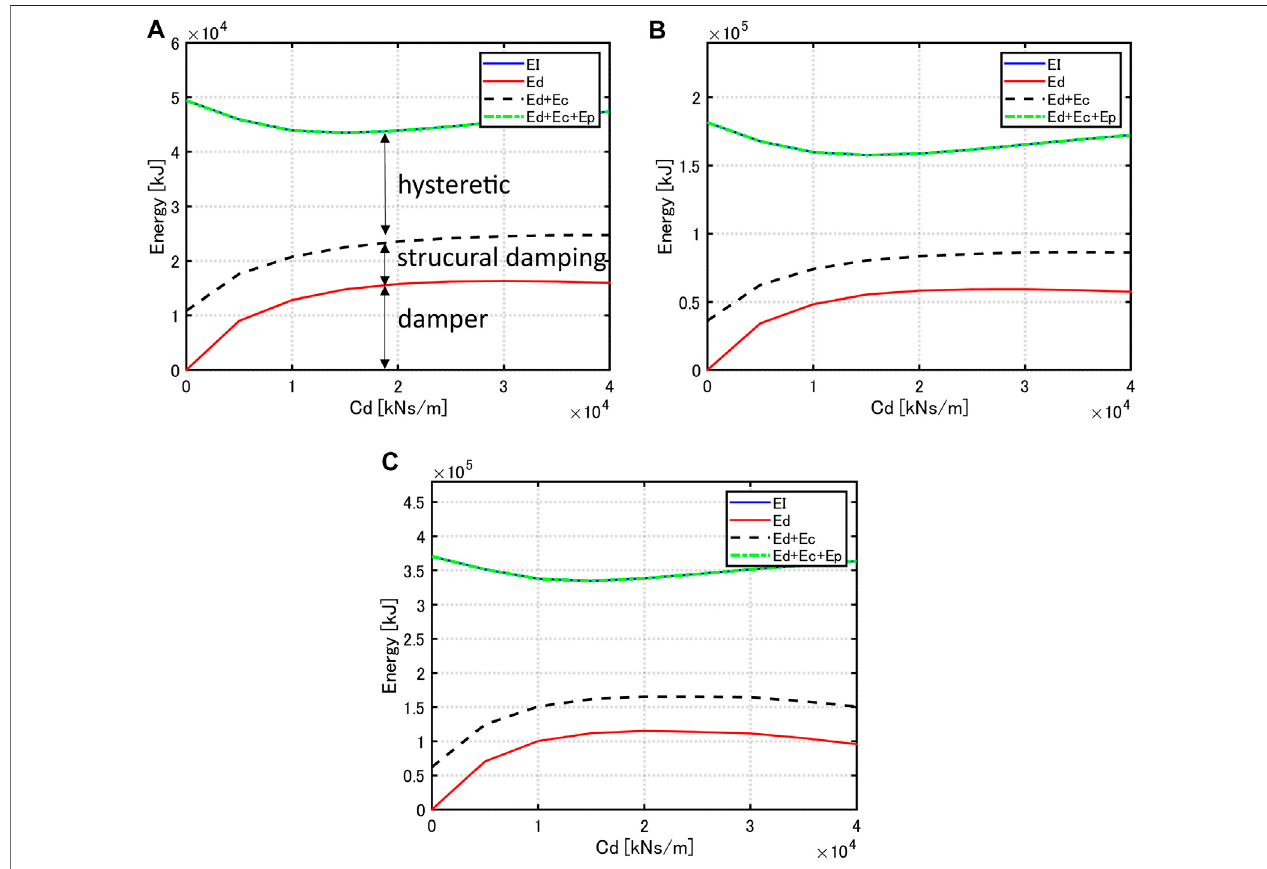
FIGURE 13 | Energy response with respect to damper quantity under critical multi impulse, (A) V MI (cid:1) 0 . 20 [ m / s ] , (B) V MI (cid:1) 0 . 40 [ m / s ] , (C) V MI (cid:1) 0 . 60 [ m / s ] .